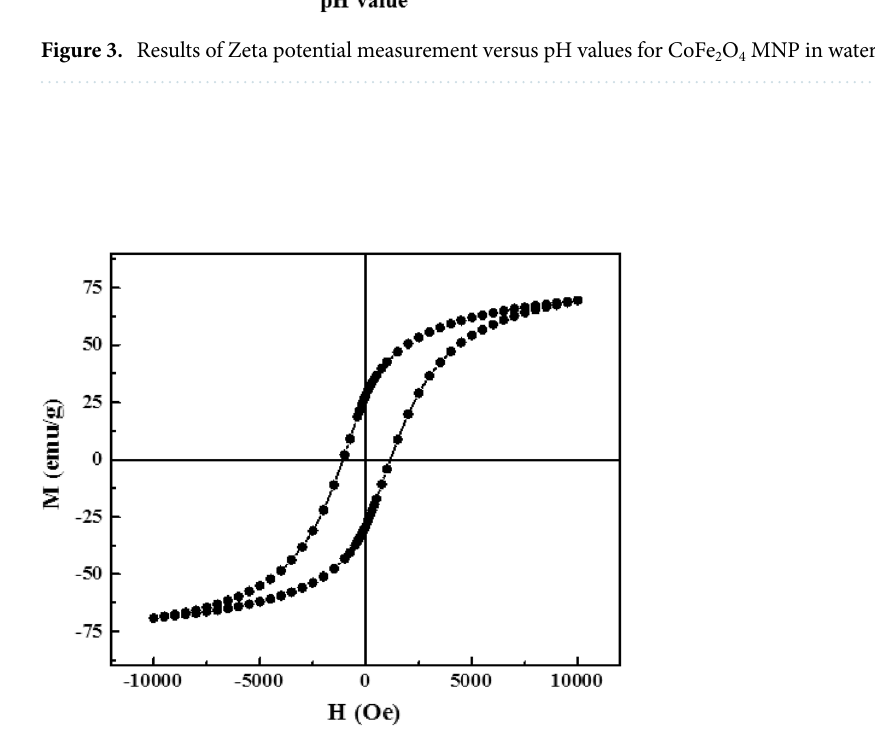
Figure 4. The typical recorded hysteresis loop of the CoFe 2 O 4 magnetic